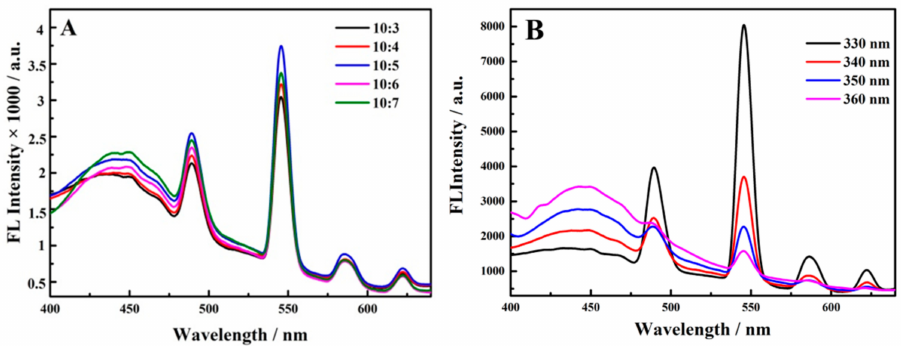
Figure 3. ( A ) The Cu NCs were added to Tb-GMP in different ratios. ( B ) The determination of the optimal excitation wavelength of Cu